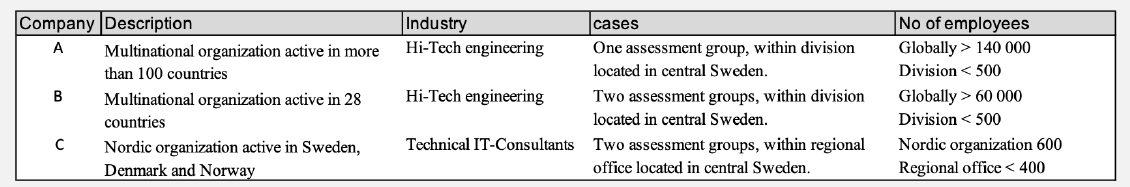
Table 1. Description of the case